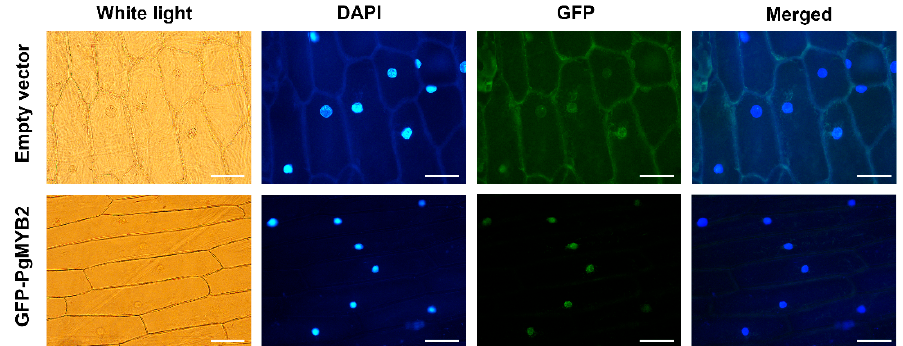
Figure 3. The subcellular localization of PgMYB2 protein in onion epidermal cells. Scale bar = 100 μ m.